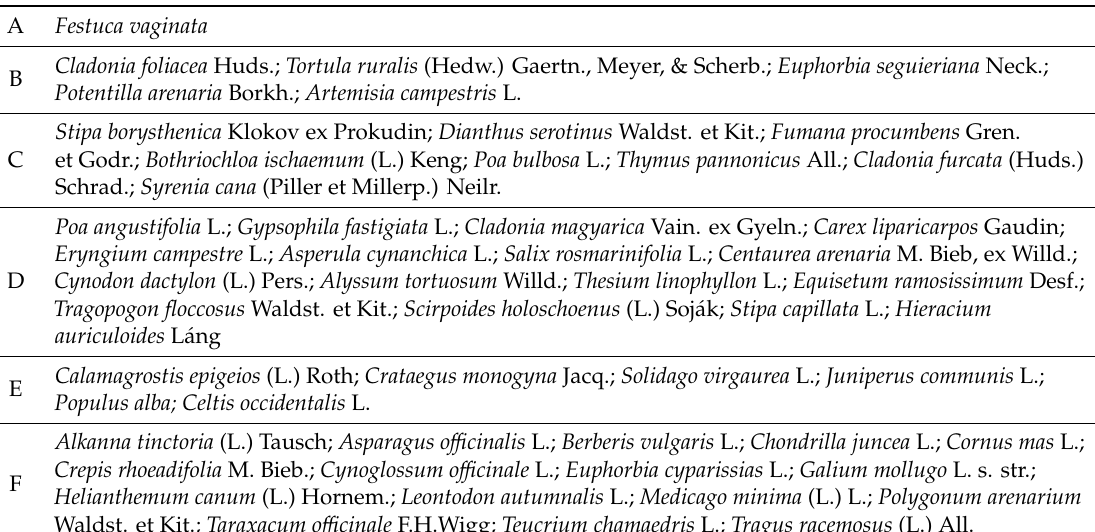
Figure 7. Principal coordinate analysis (PCoA) ordination of VPD quantiles in each transect in July 2018; 95 % confidence ellipses are drawn according to vegetation patches. Table 1. Species groups of the SE–NW transect ordered according to Figure 8. (A) ubiquitous species; (B) species occurring in the grassland; (C) species occurring on the south-eastern side of the grassland; (D) species occurring on the north-western side of the grassland; (E) species occurring in the grove; (F) low-frequency species not marked in Figure